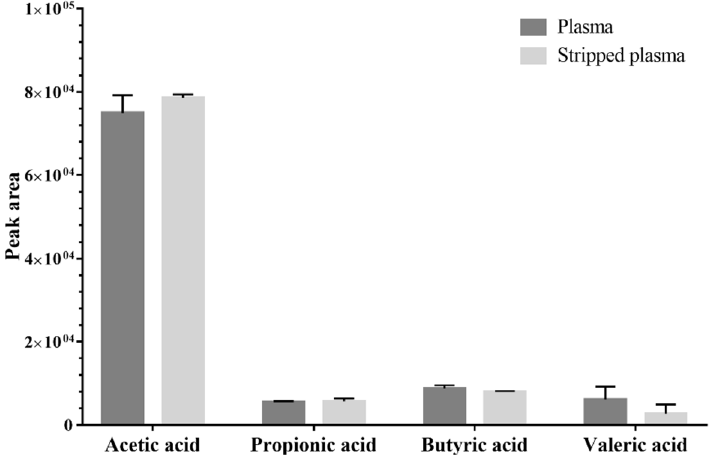
Figure A4. Baseline peak area of SCFAs in plasma and charcoal-stripped plasma ( n = 3, mean ± standard deviation). Table A1. Spike recovery results between water and serum, feces, and cecum ( n = 3, mean ± standard deviation).